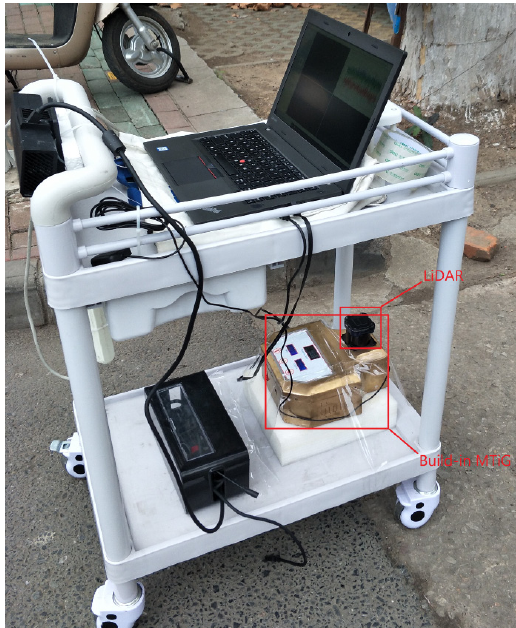
Figure 3. The LiDAR/IMU integrated system. Figure 3. The LiDAR / IMU integrated